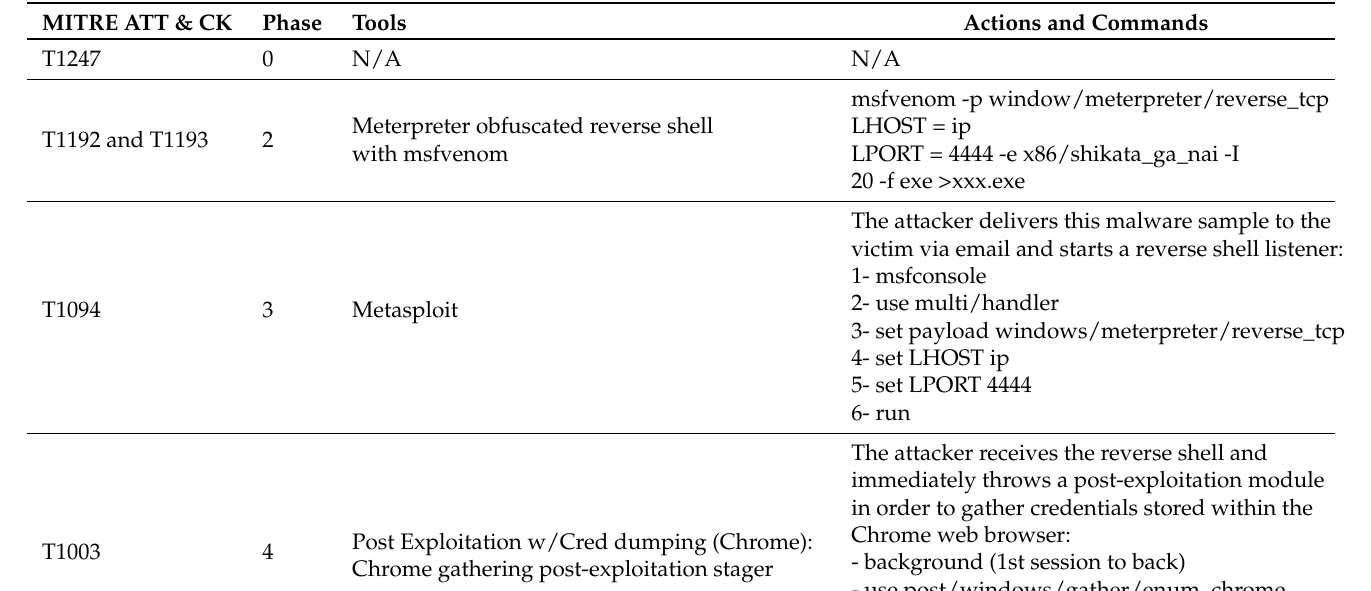
Table 4. Detailed steps to perform the attack in Scenario 3.